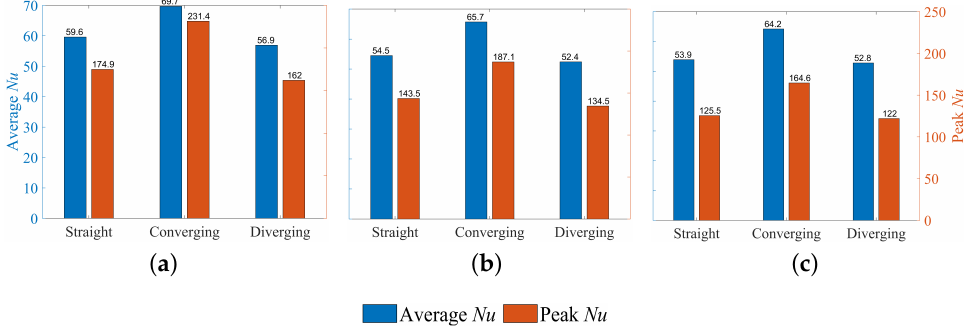
Figure 21. Average and peak Nusselt number on the target surface at ( a ) H = 0.5, ( b ) H = 2, and ( c ) H =